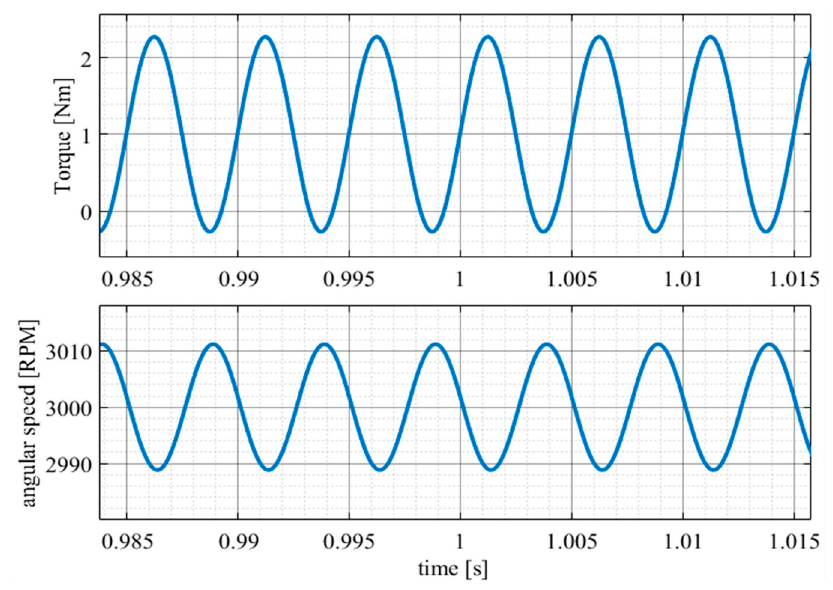
Figure 1. Example of the torque and corresponding speed: torque ( top ); speed ripple ( bottom ). The torque consists of an active mean value component T av and non-active oscillating components T osc . The total torque course may change depending on rotating speed